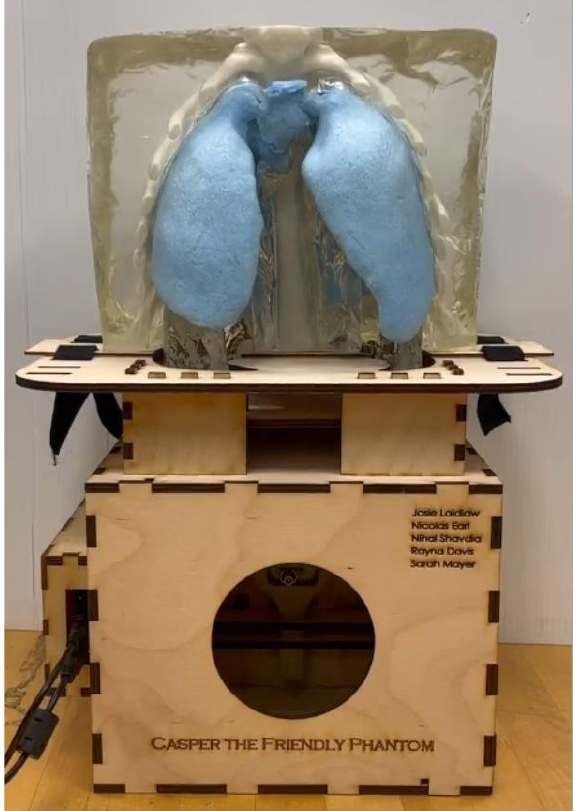
Figure 1. The fully assembled breathing phantom (CASPER) with one side of torso removed. This phantom is used to tune algorithms to account for lung movements. phantom is used to tune algorithms to account for lung